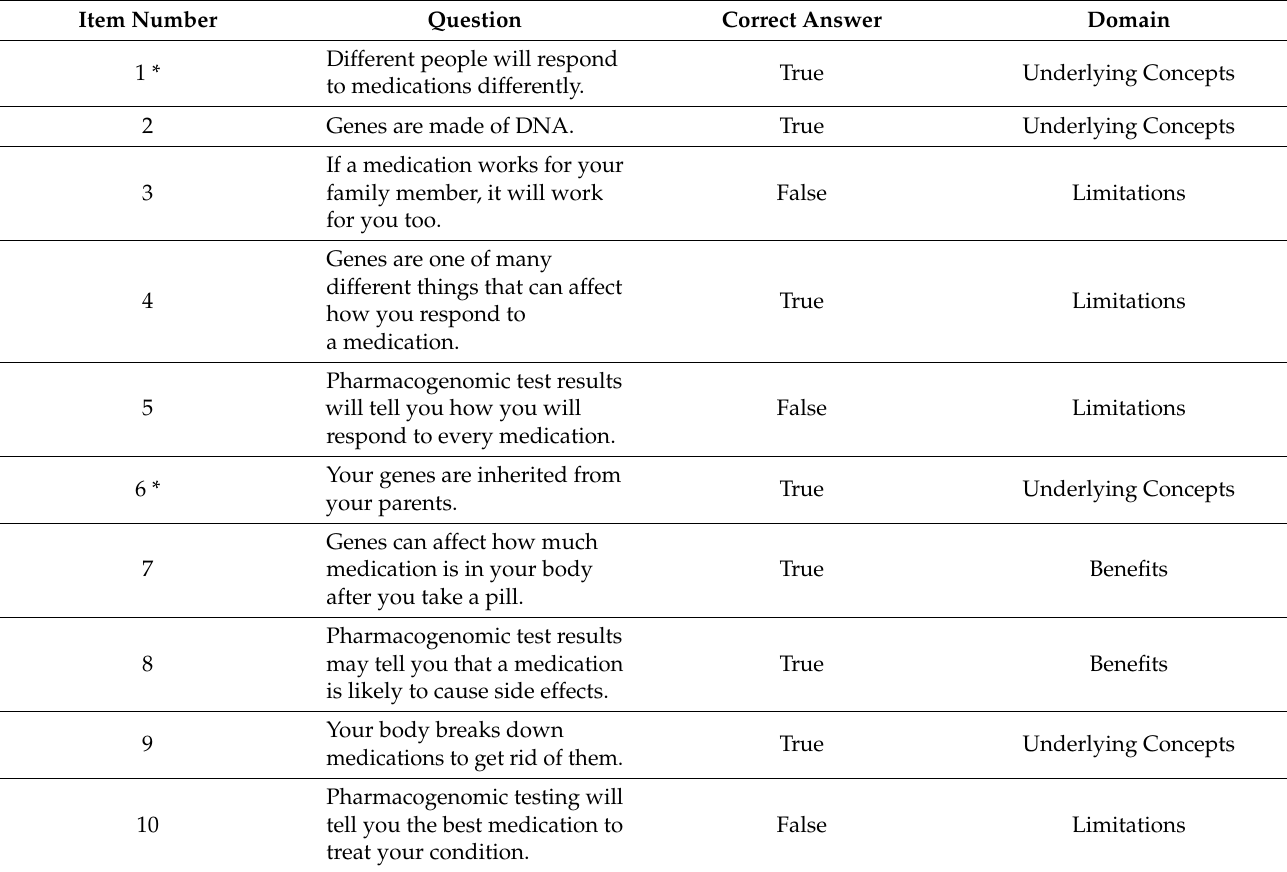
Table 1. Minnesota Assessment of Pharmacogenomic Literacy with answers and